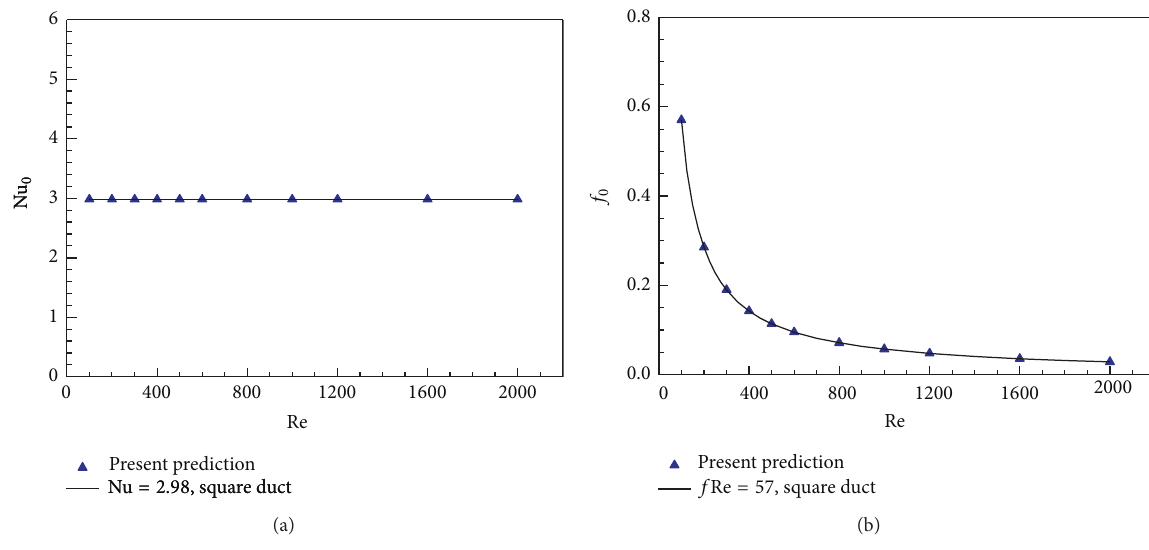
Figure 2: Verification of (a) Nusselt number and (b) friction factor for smooth square